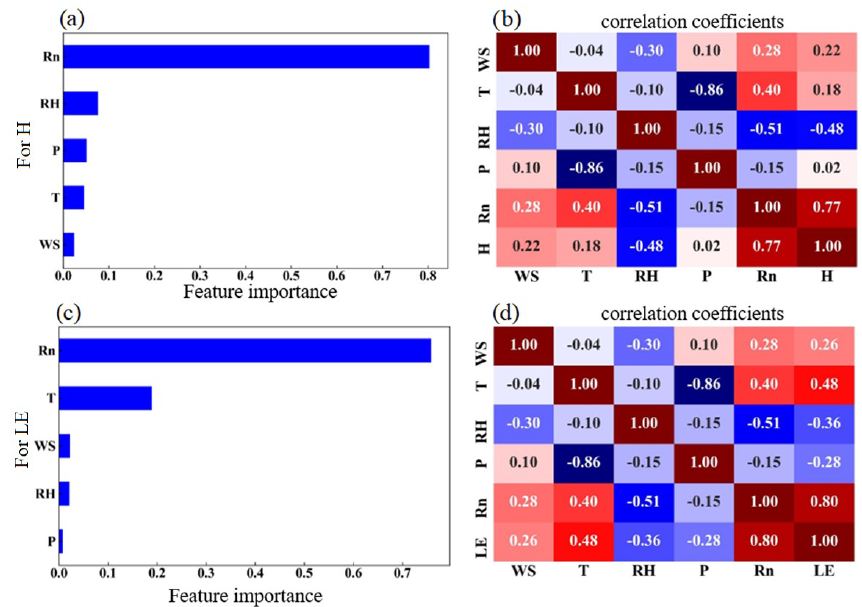
Figure 4. The feature importance of the variables for (a) H and (c) LE, and the correlation coefficient between each of the input variables for (b) H and (d)